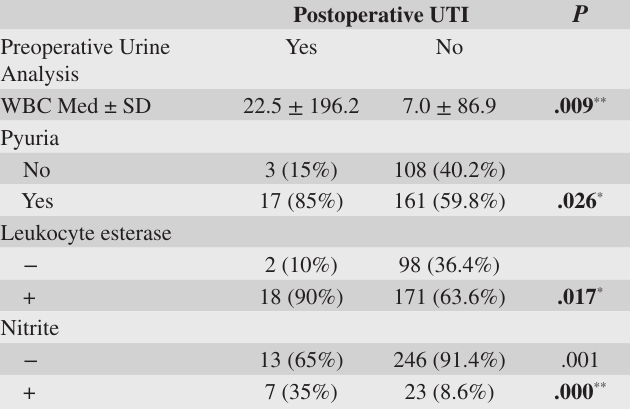
Table 2. Relationship Between Preoperative Urine Analysis and Postoperative